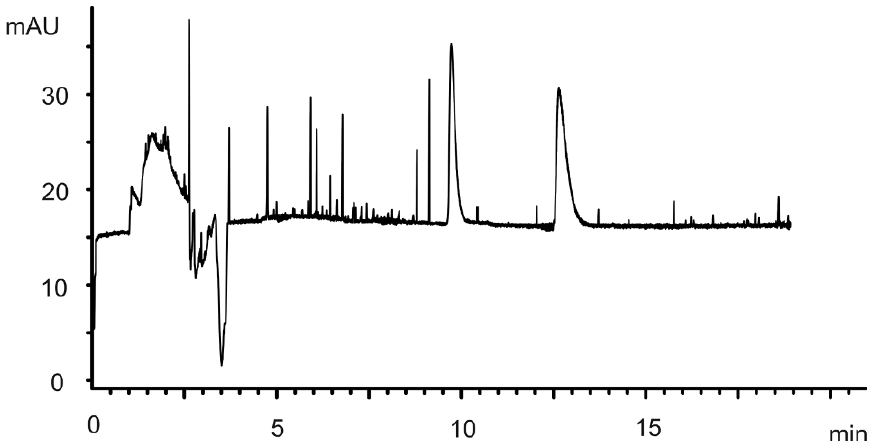
Figure 3. An electropherogram of the on-line electrokinetic preconcentration of ketoprofen enantiomers in waste waters. Injection electrolyte: 50 mmol L -1 borate/NaOH pH 9.5; BGE: 50 mmol L -1 phosphate/NaOH pH 2.5; mobilization electrolyte: 50 mmol L -1 phosphate/NaOH